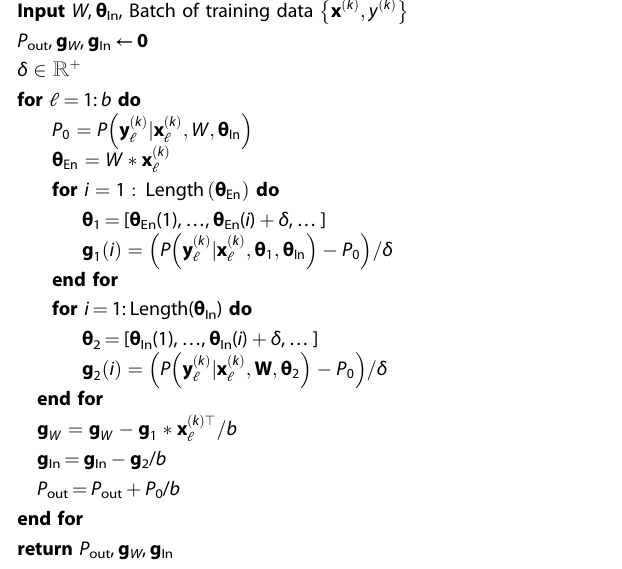
Algorithm 1 . Calculate the loss function and the gradients with respect to the model parameters